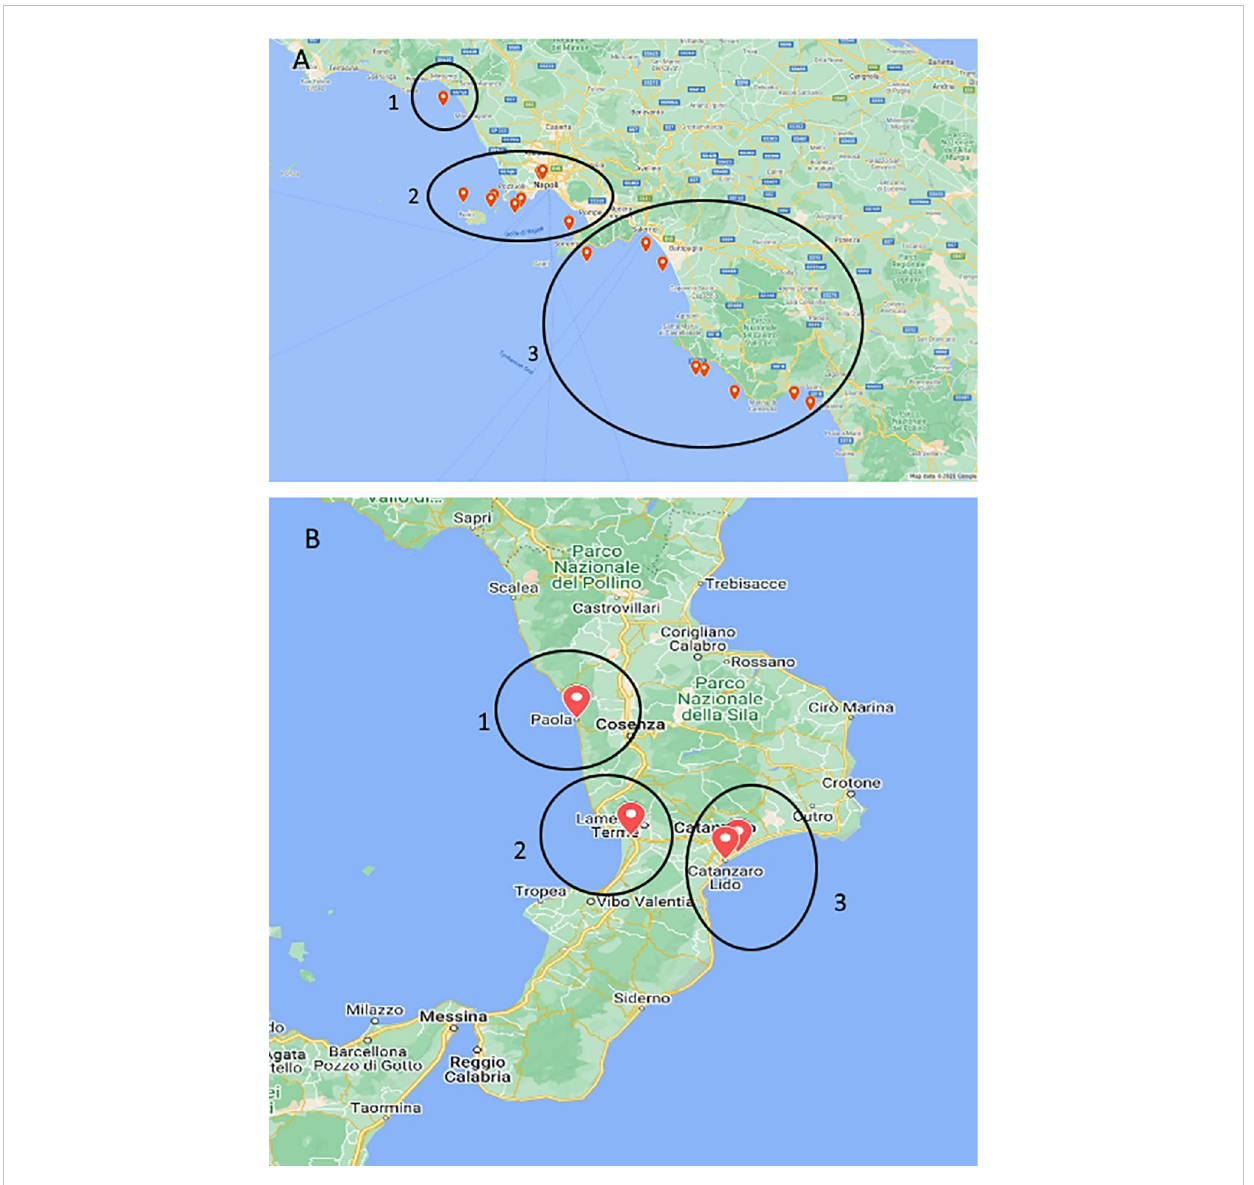
FIGURE 1 Maps of stranded Caretta caretta turtle ( n = 195) sampling sites. In the circle, ChHV5-positive animal collection sites. (A) Campania region: 1, Caserta province; 2, Naples and islands; and 3, Salerno province. (B) Calabria region: 1, Cosenza province; 2, Vibo Valentia area; and 3, Catanzaro